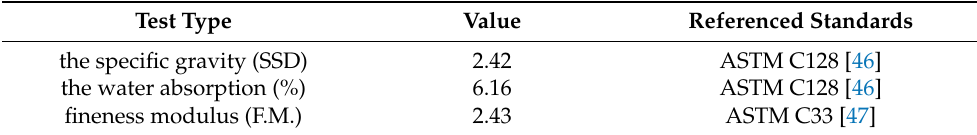
Table 7. Physical properties of recycled fine aggregate.